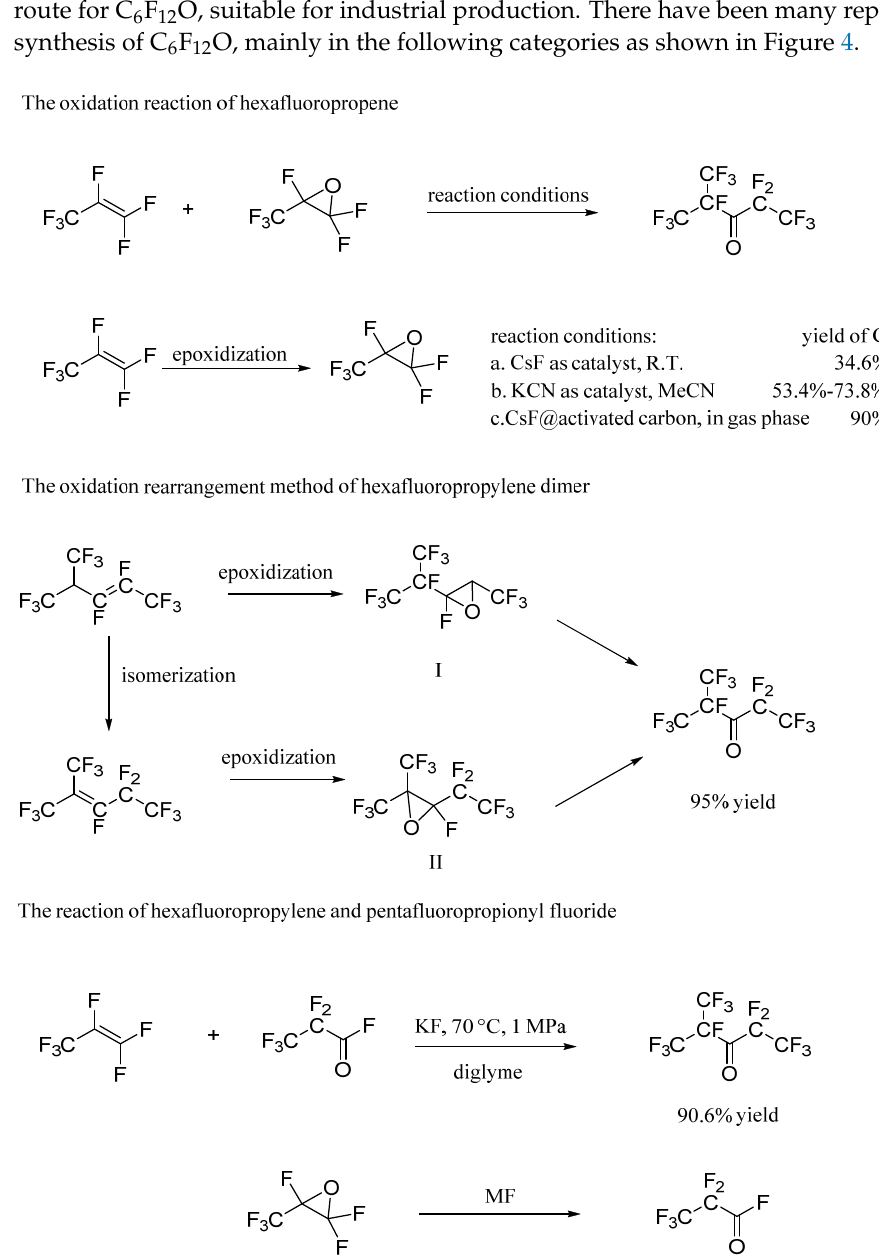
Figure 3. Device for improving the dispersibility of C 6 F 12 O by mixing inert gas [45]. Reprinted with permission from Ref. [45]. 2019, IEEE.